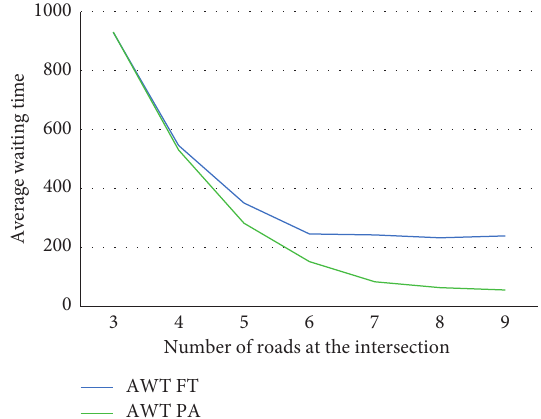
Figure 22: Effect of changing the number of roads at the intersection (all the roads have the same traffic density that decreases with the increase of the number of roads) on the average waiting time.